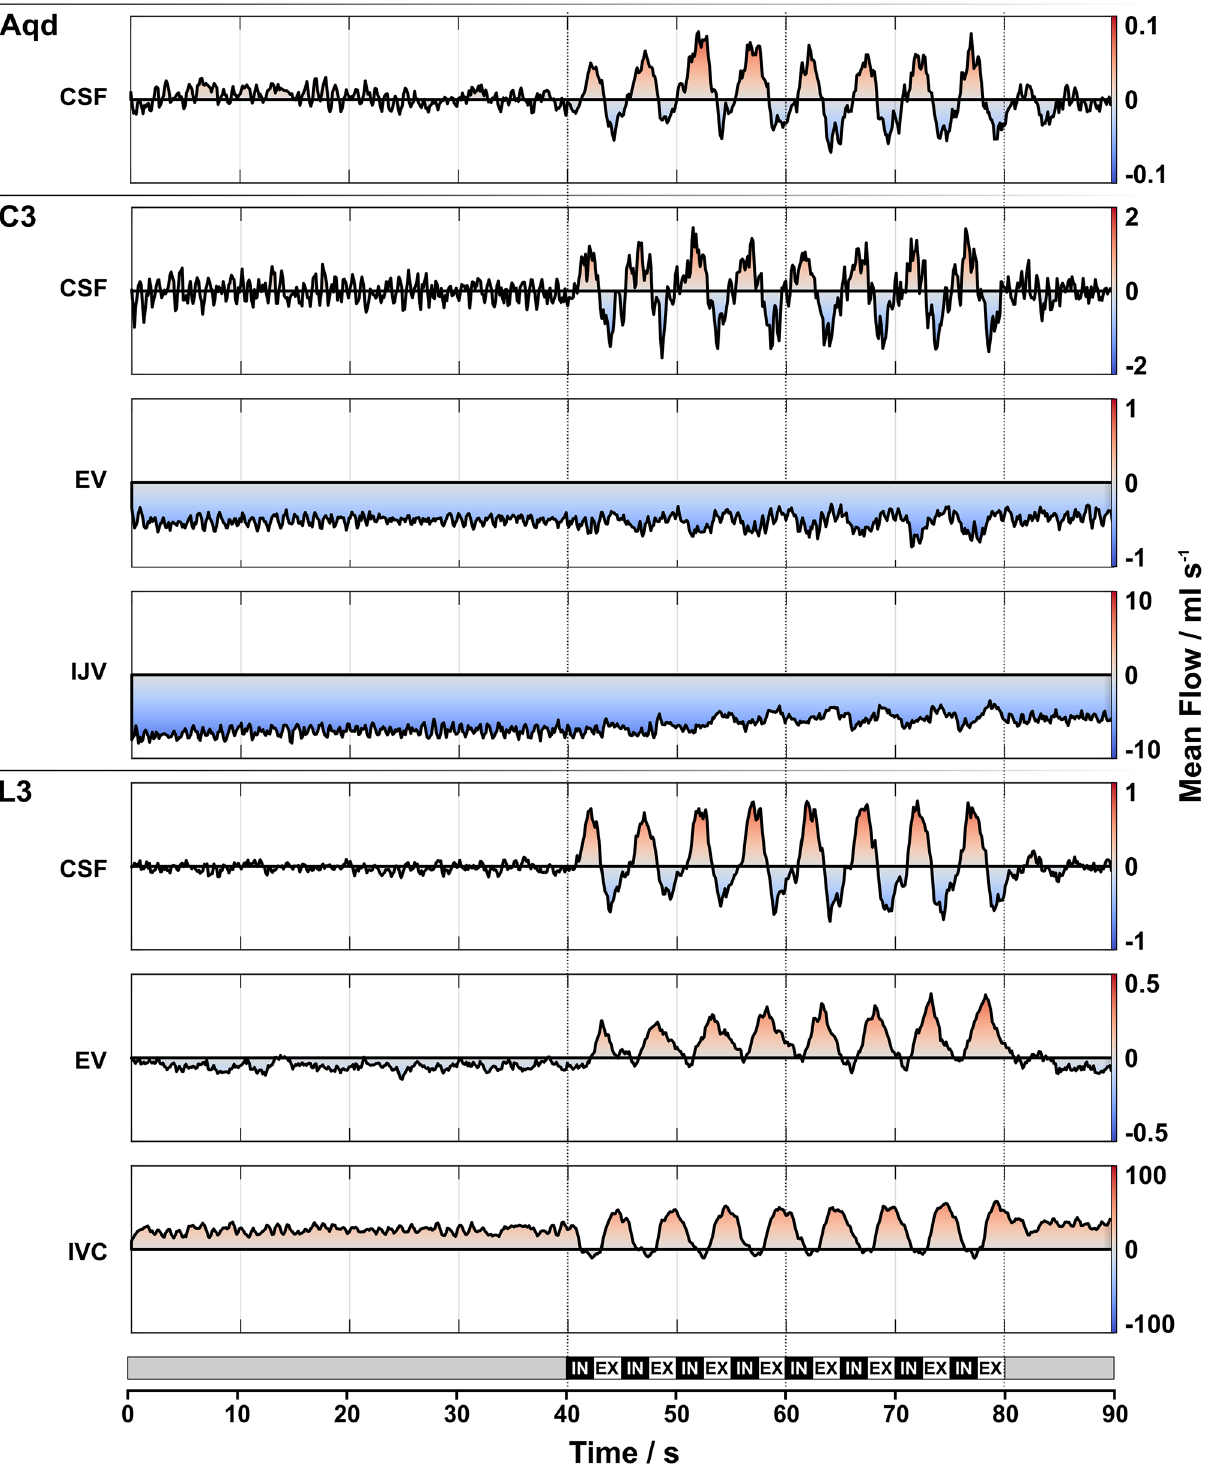
Figure 3. Mean CSF and venous flow. Color-coded mean flow rates (ml s −1 ) of CSF and venous blood averaged across subjects at all locations during the 90 s breathing protocol (bottom). The procedure largely removes the cardiac component. Note the different scaling for the various ROIs. Normal breathing (0–40 s): low CSF flow with cardiac pulsatility. Venous flow in C3-EV and IJV remains constantly negative (blue). IVC shows upward (red) flow. Mean L3-EV flow is close to zero with a tendency towards the downward direction (light blue). Forced breathing (40–80 s): synchronous flow of CSF and venous blood following respiratory modulations. CSF moves upwards with IN in all ROIs (red) and downwards during EX (blue). Venous blood in the vessels at C3 shows downward flow with only small modulations. In L3-IVC flow modulations are more pronounced i.e. assuming a decrease during IN and an increase during EX. Flow in L3-EV yields a similar behavior. Normal breathing (80–90 s): rapid return of CSF and blood flow to the initial pattern. Aqd = aqueduct, C3 = cervical level 3, L3 = lumbar level 3, EV = epidural veins, IJV = internal jugular vein, IVC = inferior vena cava, IN = inspiration, EX =